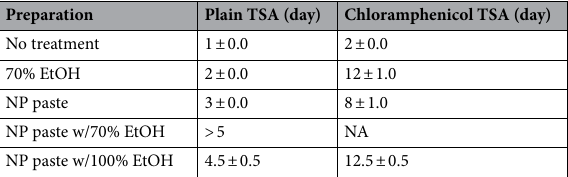
Table 1. Day of culturable microbial growth on TSA agar.